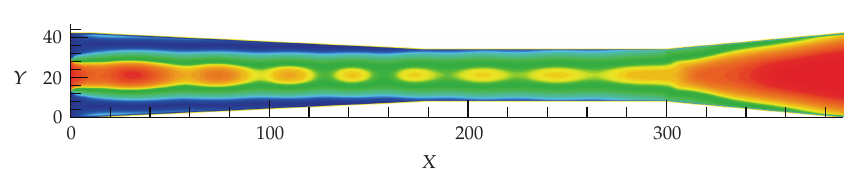
Figure 23: Mach number through the di ff user section at 5.0s.